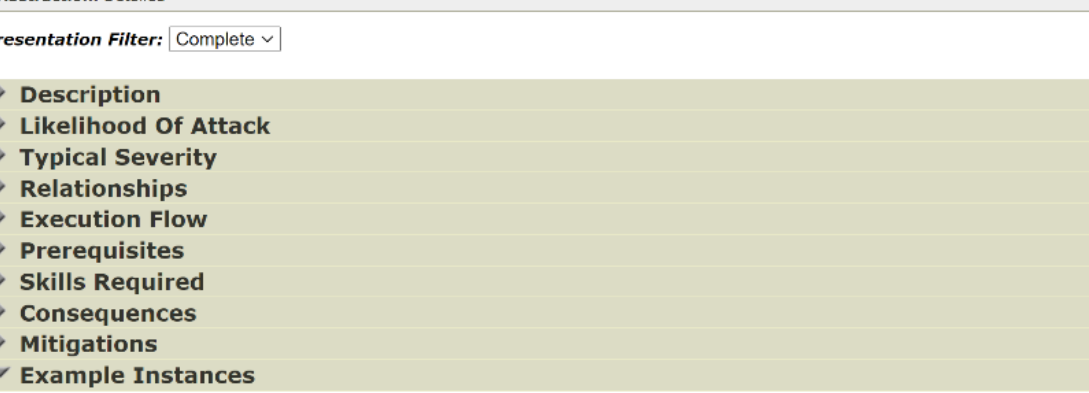
Figure 7. CAPEC-60 web page.